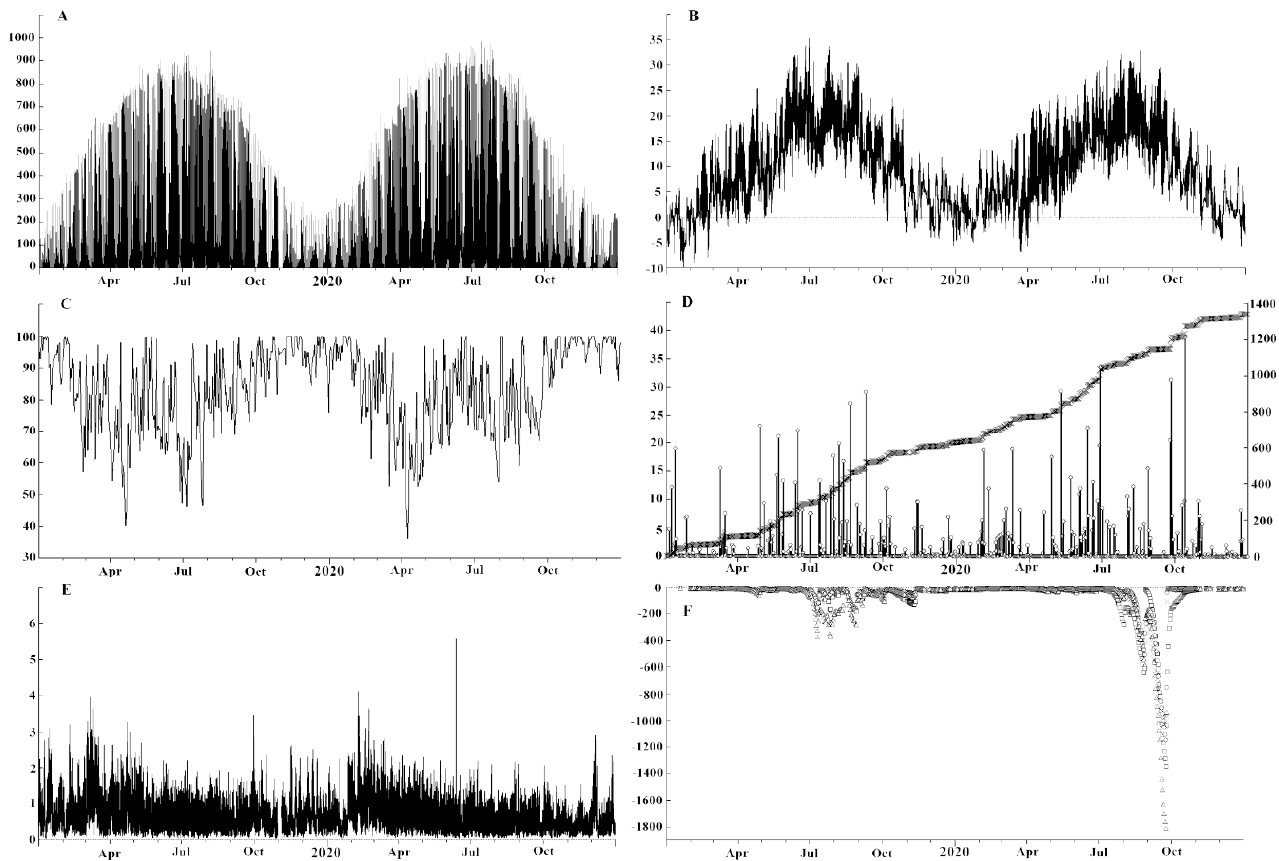
Figure 2. Temporal pattern in meteorological parameters during the study period at the study site. ( A ): global radiation (W·m − 2 ), ( B ): air temperature (°C), ( C ): relative humidity (%), ( D ): precipitation and cumulative precipitation (mm), ( E ): wind speed (m s − 1 ), ( F ): soil-water potential (kPa) of the study plots (x: plot A, ○ : plot B, □ : plot C, ∆ : plot D). Table 2. Mean values (mean ± standard deviation) of some of the climate variables were measured at the study site. * Standard deviation. ** Global radiation in the column represents the mean day- time radiation. *** Daily precipitation data were obtained from annual precipitation by dividing them by 365.